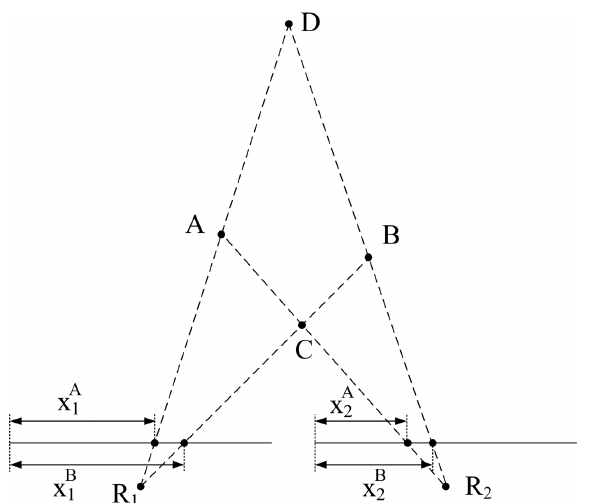
FIGURE 14 | Illustration of matching errors.